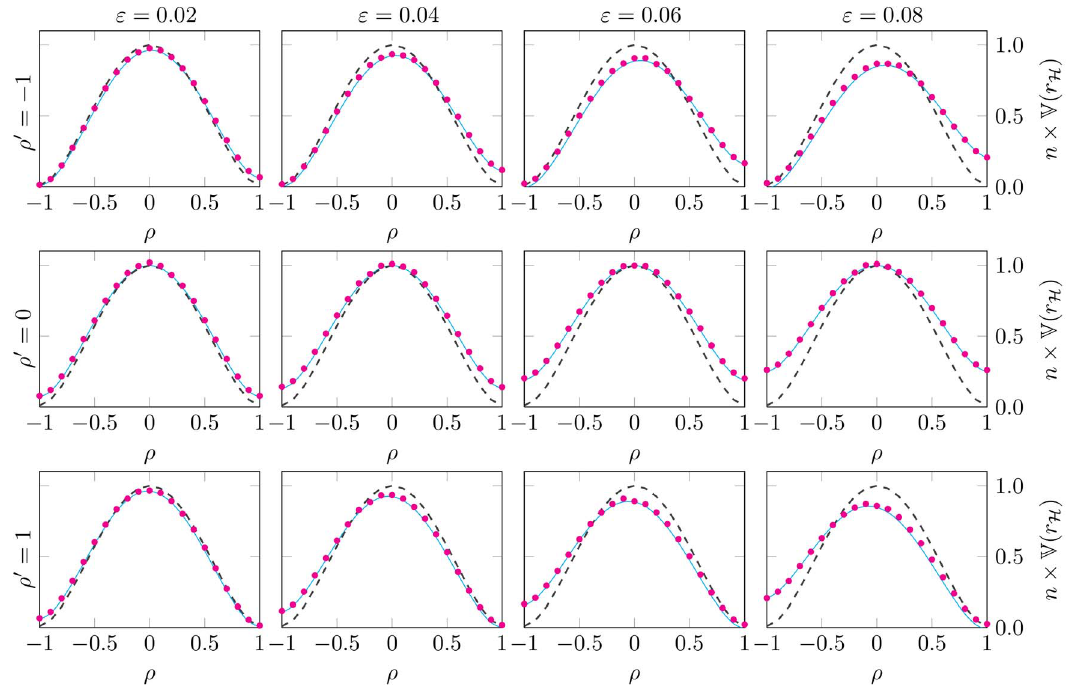
Figure 2. The numerical verification of (22), the variance of r H in Theorem 1. The number of samples is chose as n ~ 100 . In the vertically up direction, r ’ is decreasing following f 1,0, { 1 g respectively; whereas e corresponds to a increasing trend in the horizontally right direction, following f 0 : 02,0 : 04,0 : 06,0 : 08 g respectively. It shows a good agreement between the simulation result (circles) and the theoretical computation (solid lines) in each subplot. As a reference, the contamination-free version (50) is also posted together (see dashed curves).